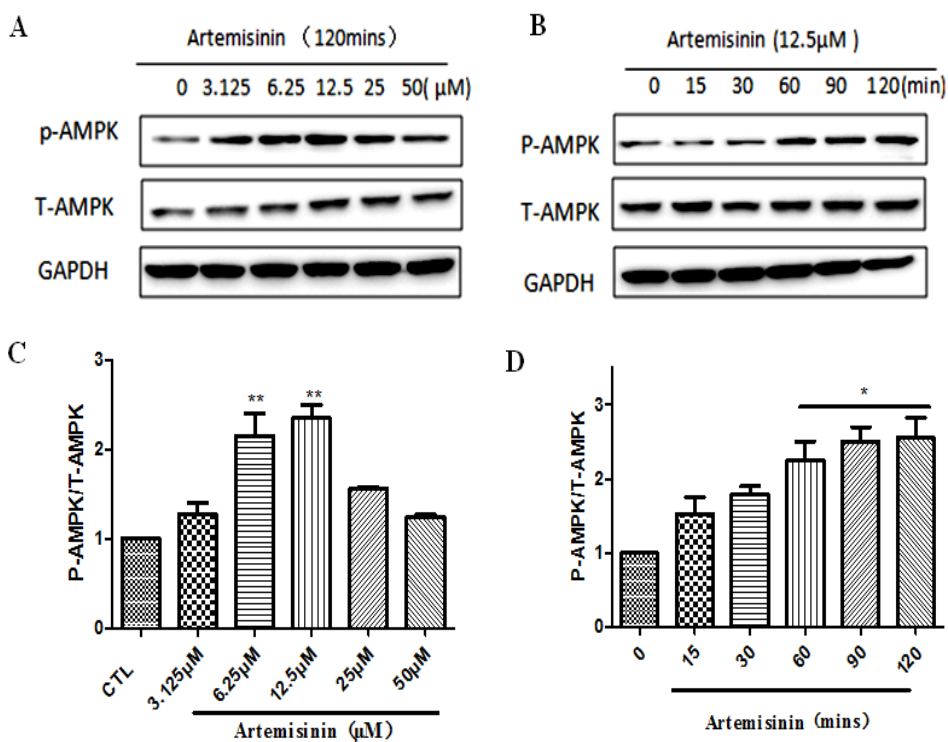
Figure 4. Artemisinin stimulated the phosphorylation of AMP-activated protein kinase (AMPK) in SH-SY5Y cells. ( A , C ) The SH-SY5Y cells were collected with artemisinin treatment for di ff erent times (0, 15, 30, 60, 90 and 120 min) at 12.5 µ M, and at di ff erent concentrations (3.15, 6.25, 12.5, 25 and 50 µ M) for 120 min. The expression of phosphocreatine AMPK, total AMPK and glyceraldehyde-3-phosphate dehydrogenase (GAPDH) were detected by western blot. ( B , D ) Quantification of representative protein band from western blotting. The data were represented as the mean ± SD. * p < 0.05, ** p < 0.01, versus the control group was considered significantly different.